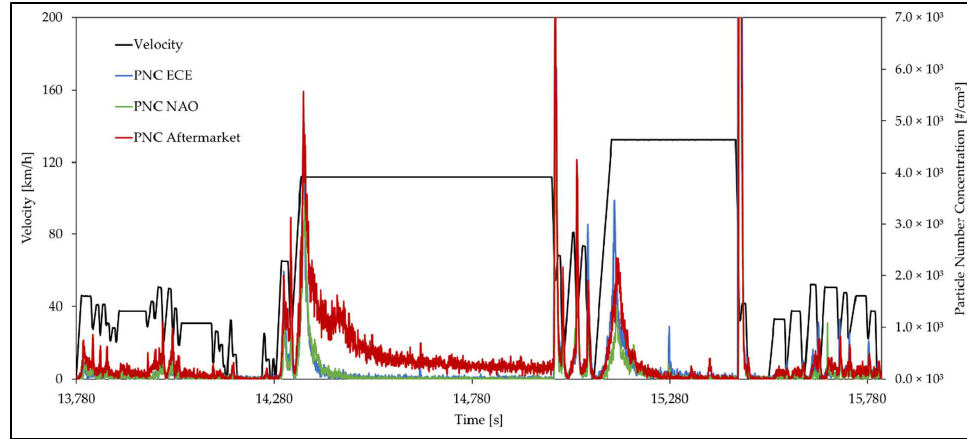
Figure 8. Evolution of particle number concentrations (SPN measured with CPC) during an excerpt of WLTP Brake Cycle Trip 10.